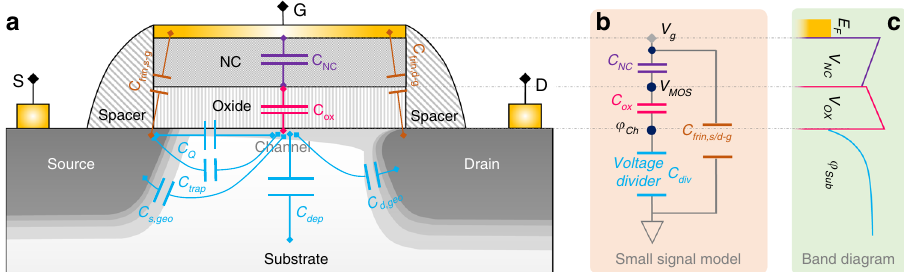
Fig. 1 Capacitors in a generic NC-FET structure and its small-signal model. a Capacitors potentially involved in determining the channel potential of a generic NC-FET. C Q , C dep , C s/d,geo , and C trap are the quantum-, depletion-, s/d geometrical, and trap induced, capacitors, respectively. C NC and C OX represent the capacitance of the NC and oxide layers, respectively. b Simpli fi ed small-signal model for NC-FETs. Note that in the small-signal model, the change in the values of the capacitances near the vicinity of a given DC bias point is negligible. C div is the voltage divider capacitance that includes C Q , C dep , C s/d,geo , and C trap . The effect of fringing capacitance, C frin,s/d-g , is screened by power rails, and hence is irrelevant to channel potential control. c The conduction band diagram of NC-FETs under a positive gate bias. Note that due to negative C NC , V NC is